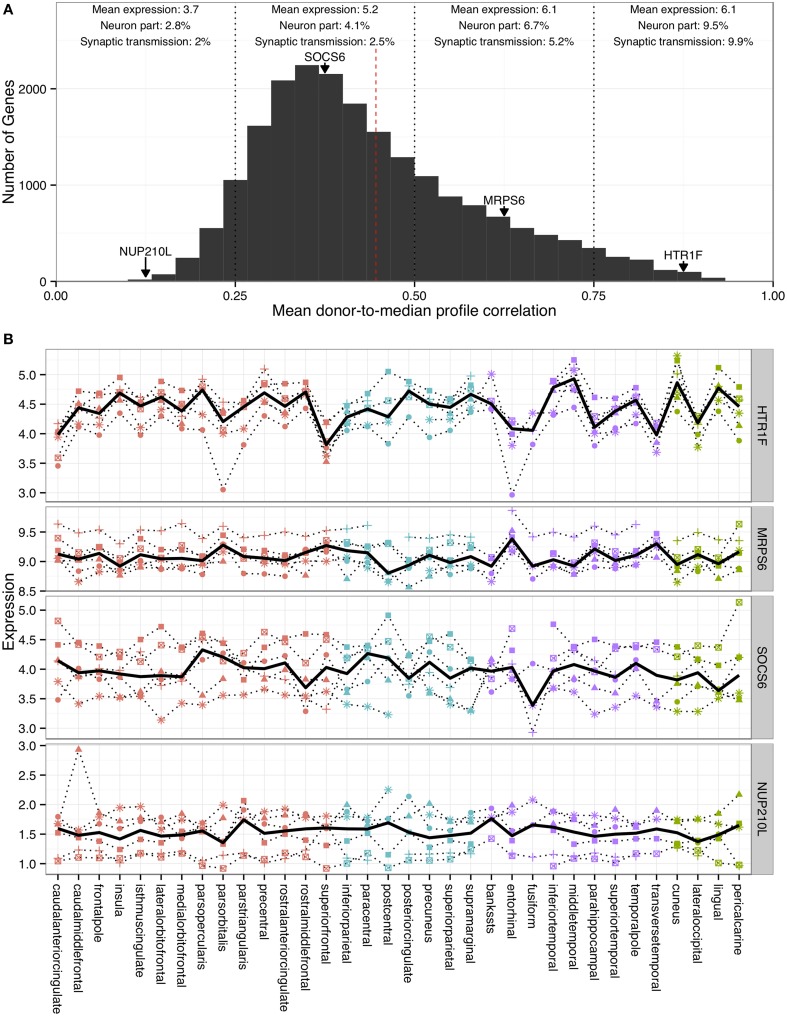
Characterization of correlations between individual donor profiles and the median profile. (A) Histogram of donor-to-median profile correlations. The dashed red line marks a correlation of 0.446, which corresponds to one sided p < 0.05 (derived from random simulations of donor expression profiles). Mean expression levels and overlaps with the “synaptic transmission” and “neuron part” gene ontology groups are provided for genes in four correlation ranges (marked as dotted vertical lines). Expression profiles for four representative genes that lie at the midpoints of each range are provided in (B) and marked in (A) with arrows (HTR1F, MRPS6, SOCS6, and NUP210L). The solid black line represents the median profile and the six donor profiles as dotted lines in (B). Each region is color-coded to indicate its cortical lobe: frontal (red), parietal (blue), temporal (purple) and occipital (green). Each symbol shape represents a specific donor.